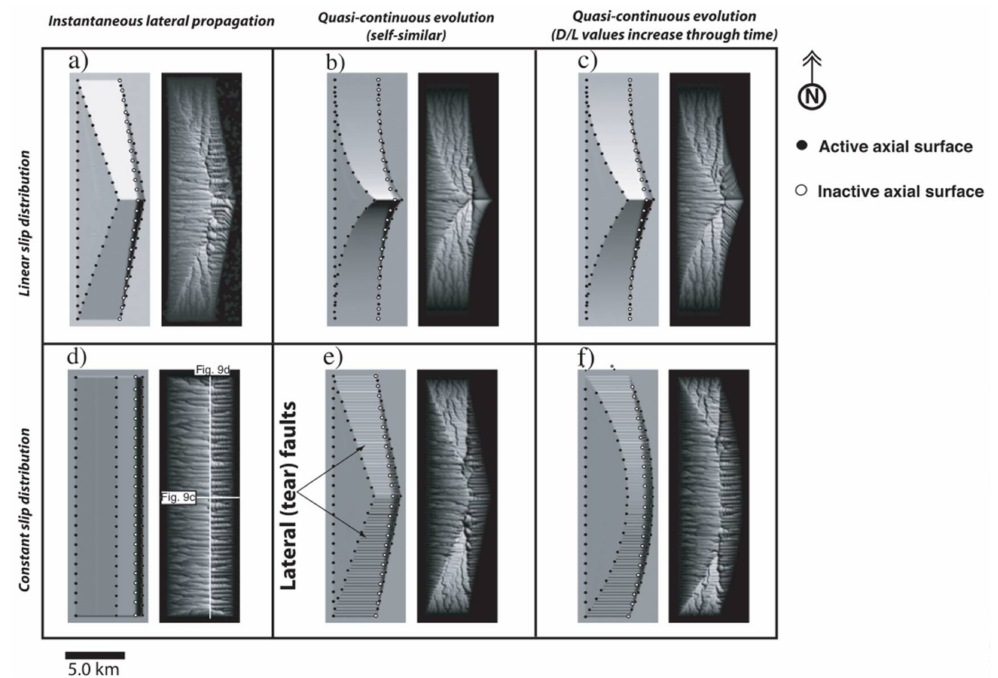
Figure 7. Final morphology of the fault-propagation fold model under different slip distributions, ( a – c ) top row linear slip distribution, ( d – f ) bottom row constant slip distribution and for styles of lengthening. Greyscale shaded relief images with illumination from NW, azimuth is 30